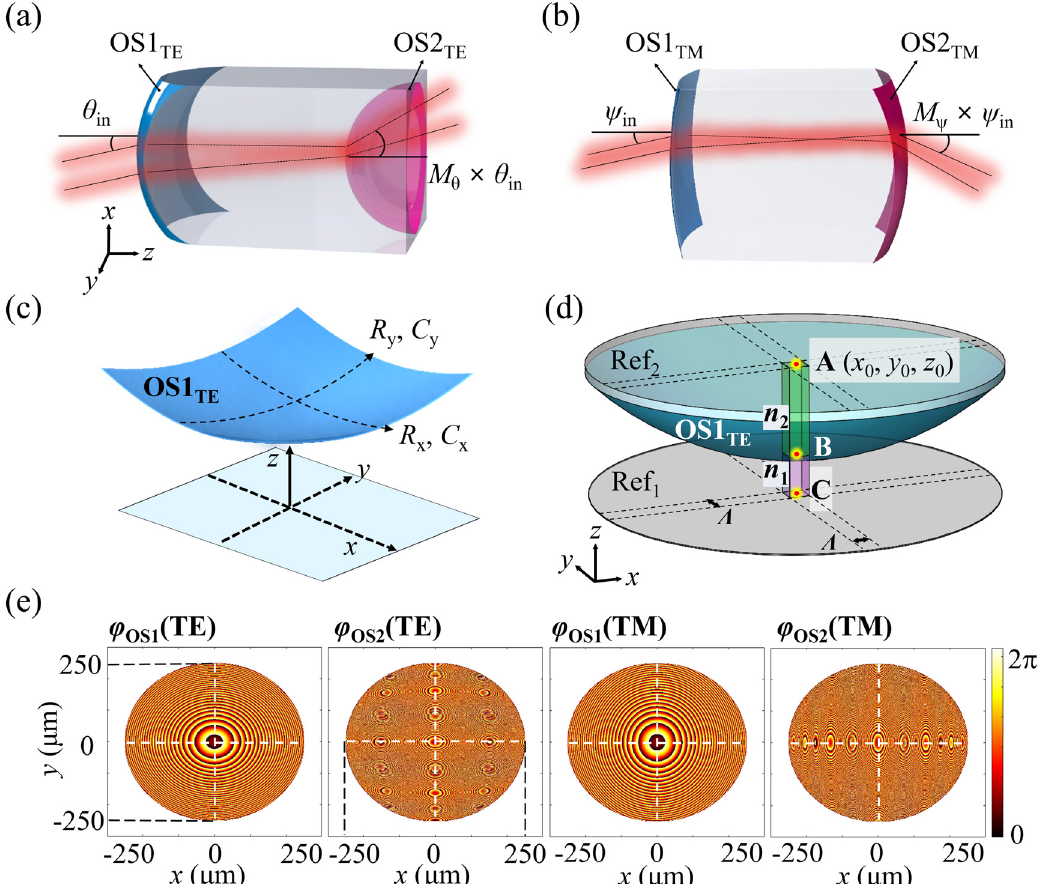
Figure 2: Design of an anamorphic lens doublet, involving phase profile calculation. Schematic configurations of lens doublets capitalizing on: (a) a convex contour OS1 TE and concave contour OS2 TE , rendering increased beam de fl ection in the positive direction, (b) double convex contours OS1 TM and OS2 TM , leading to increased beam de fl ection in the negative direction. (c) Perspective view of the anamorphic surface OS1 TE exhibitingdifferentasphericshapesinthe xz -and yz -planes.(d)Alocalphase φ lo atpointA( x 0 , y 0 , z 0 ),whichisimpartedtotheincoming beam, is determined by the sum of the cumulated phase contributions from the paths connecting points C to B and points B to A, through different media. (e) Calculated relative phase pro fi les for OS1 TE , OS2 TE , OS1 TM , and OS2 TM